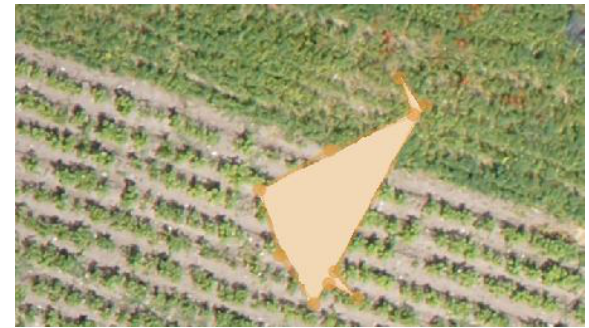
Figure 13. Lack in coverage on UAV